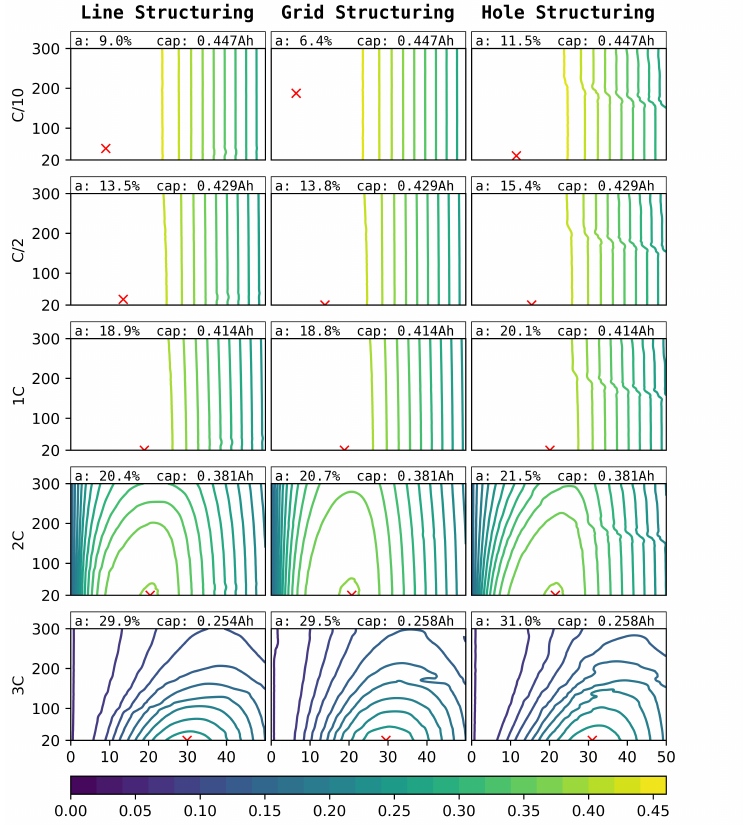
Figure 9. Simulated discharge capacities (Ah) for different C-rates (outer y-axis), laser pitches ((µm), inner y-axis), structure types (outer x-axis), and degrees of ablation of the anode ((%), inner